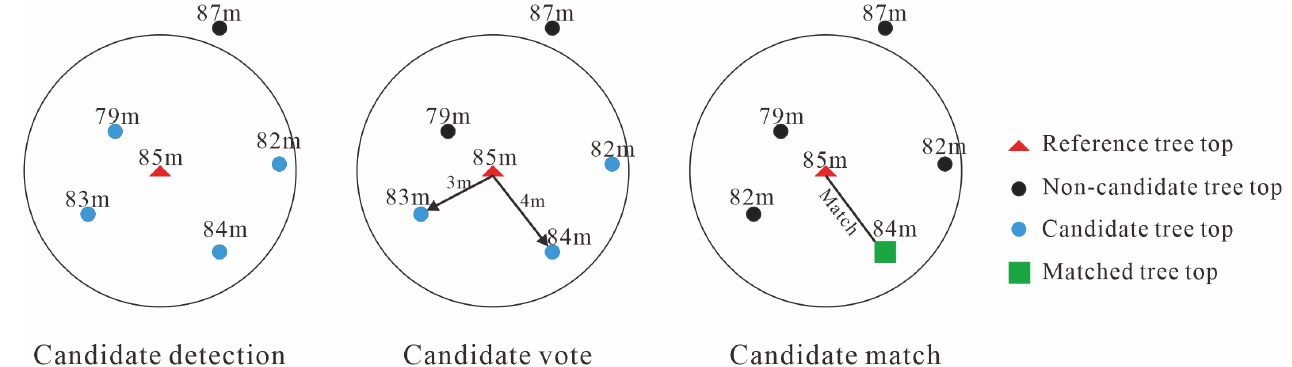
10 of 19 Table 1. The characteristics of the four testing datasets. Area Total Points Tree Points Non-Tree Points